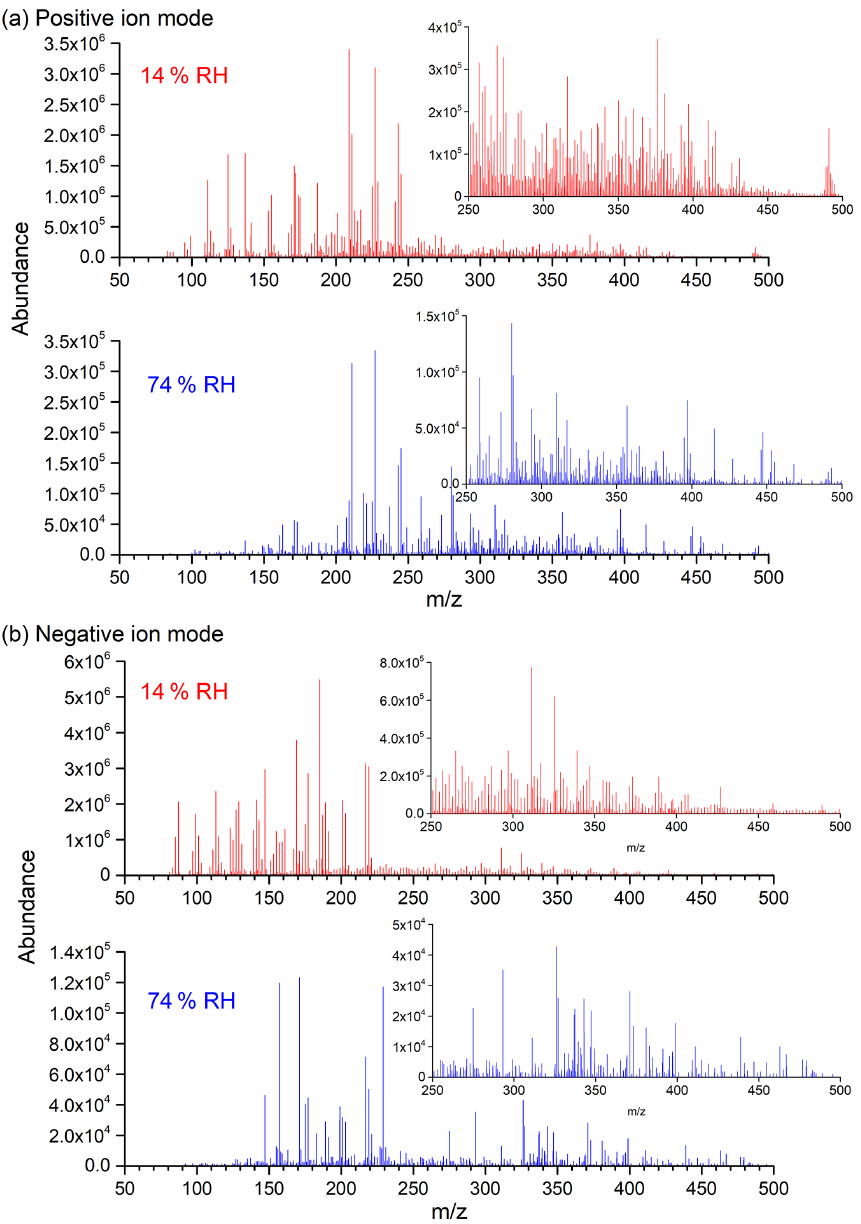
Figure 4. Background-subtraction HESI-Q Exactive-Orbitrap MS results of SOA in positive (a) and negative (b) ion modes from the pho- tooxidation of m -xylene–OH under both 14% (Exp. 2) and 74% (Exp. 8) RH conditions (note that the y axis scales for low and high RH are largely different: 10 6 at low RH and 10 5 at high